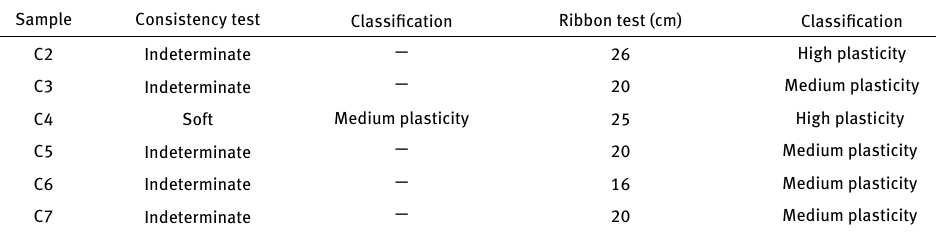
Table 7: Consistency and ribbon test results.